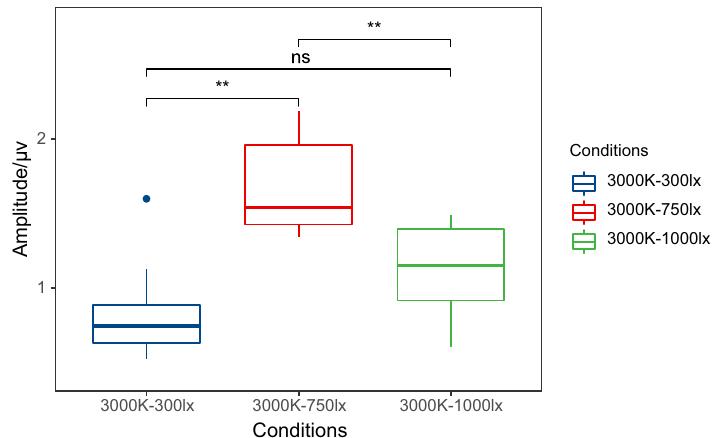
Figure 5. An example of P3b amplitudes with different illuminance levels under 3000 K colour temperature at the P4 electrode (*P < 0.05; **P < 0.01). The amplitude at 750 lx was significantly higher, indicating that the lowest mental workload occurred at 750 lx.